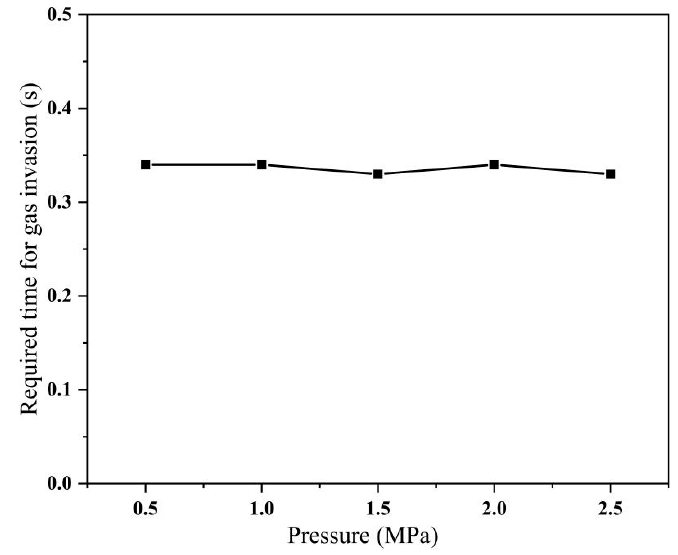
Figure 10. Time required for gas invasion under different pressures.